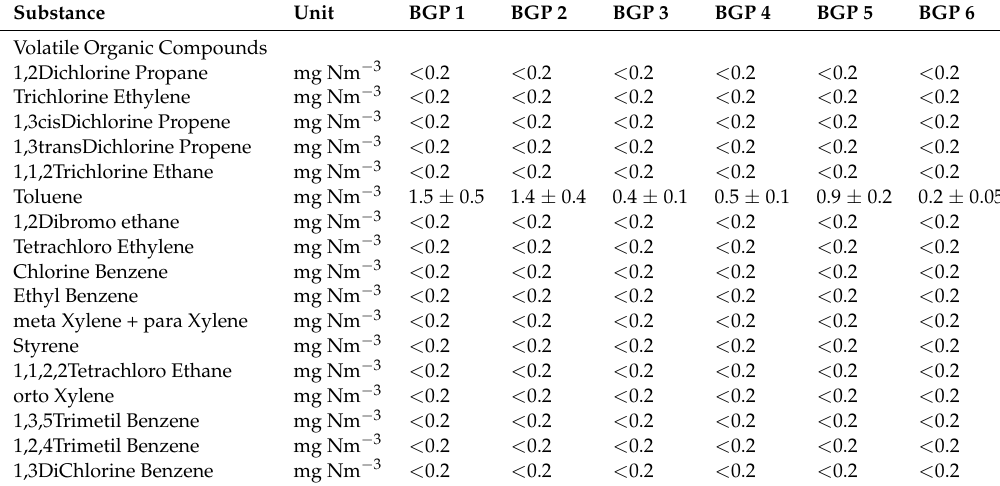
Table 12. Biogas composition—part 5.